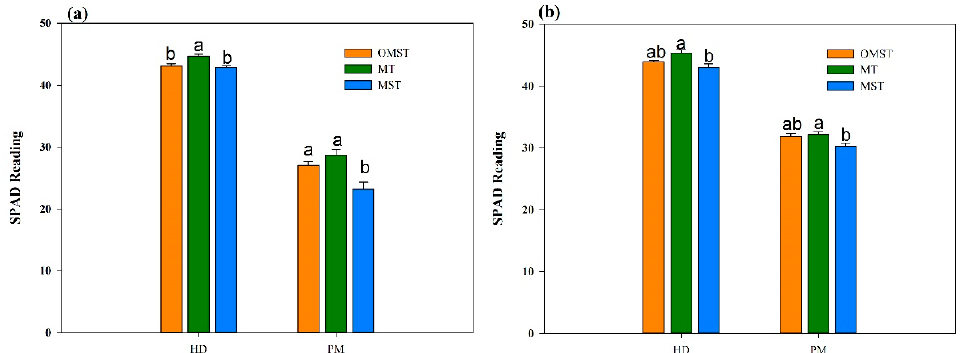
Figure 9. The SPAD reading of the flag leaf under different rice establishment methods: ( a ) Xiangzaoxian24; and ( b ) Zhongzao39. OMST: Orderly mechanical seedling throwing, MT: Manual transplanting, MST: Manual seedling throwing, XZX24: Xiangzaoxian24, ZZ39: Zhongzao39, T: Middle tillering stage, PM: Physiological maturity stage, HD: Heading stage. Different lowercase letters denote statistical differences among treatments of a cultivar at the 5% level according to LSD test. Error bars above mean indicate standard error ( n =